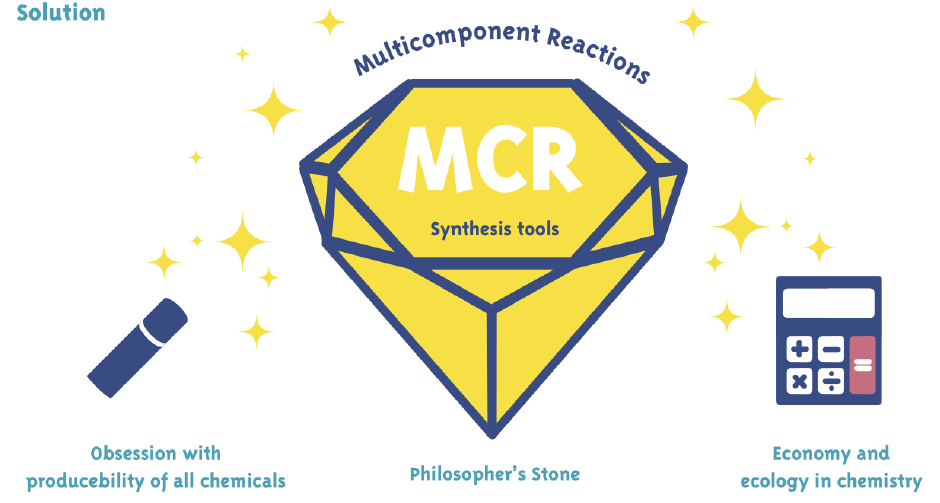
Figure 7. Solution of the discrepancy in Section Prologue in performing syntheses by concerted simplification in an elegant and highly efficient way.